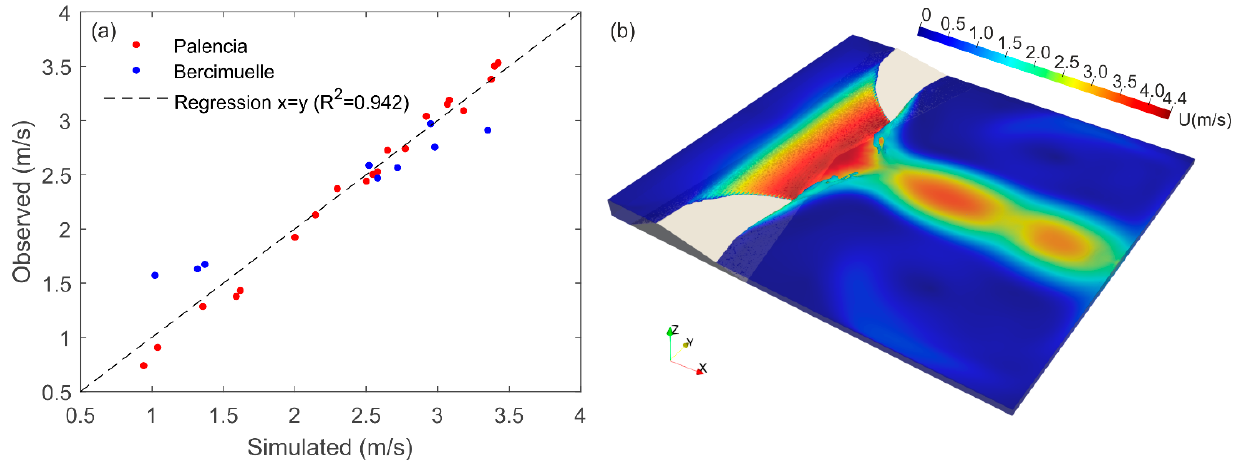
Figure 4. ( a ) Validation of the 3D model results considering field measurements (R 2 stands for determination coefficient); ( b ) Simulation example of the flow velocity (U) for the Palencia weir (p = 0.7 m, h 1 = 1.23 m; Q = 6 m 3 /s, d 2 = 0.46 m).